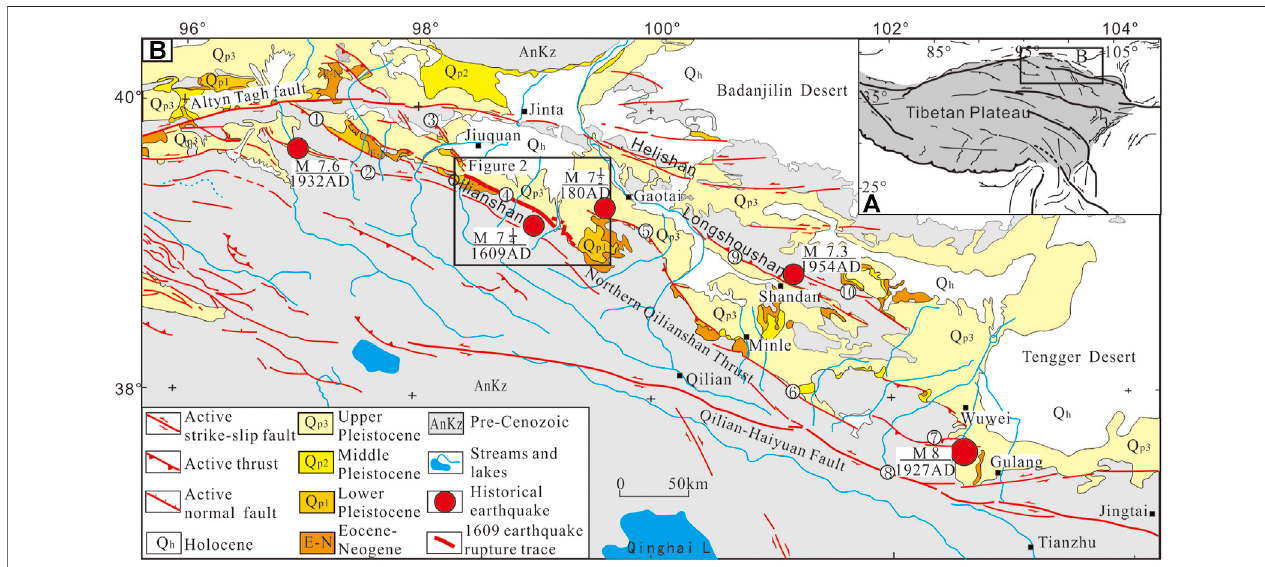
FIGURE 1 | (A) Active tectonics map of northeastern Tibet (after Xu et al., 2010). Fault labels in (B) include: 1) Hanxia – Dahuanggou thrust; 2) Changma fault; 3) Jiayuguanthrust;4)Fudongmiao – Hongyazithrust;5)Yumushanthrust;6)Minle – Damayinthrust;7)Dongqingdingthrust;8)Lenglonglin;9)southLongshoushan thrust; 10) Baode